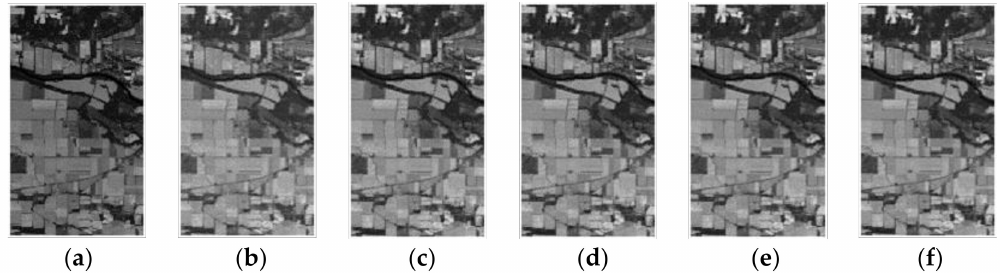
Figure 5. The Original image and reconstructed image with band number 180, the compressed sensing algorithm is based on the CDL-OMP algorithm, ( a ) The original images; ( b ) The sampling rate of the reconstructed image is SR = 0.1; ( c ) The sampling rate of the reconstructed image is SR = 0.2; ( d ) The sampling rate of the reconstructed image is SR = 0.3; ( e ) The sampling rate of the reconstructed image is SR = 0.4; ( f ) The sampling rate of the reconstructed image is SR =